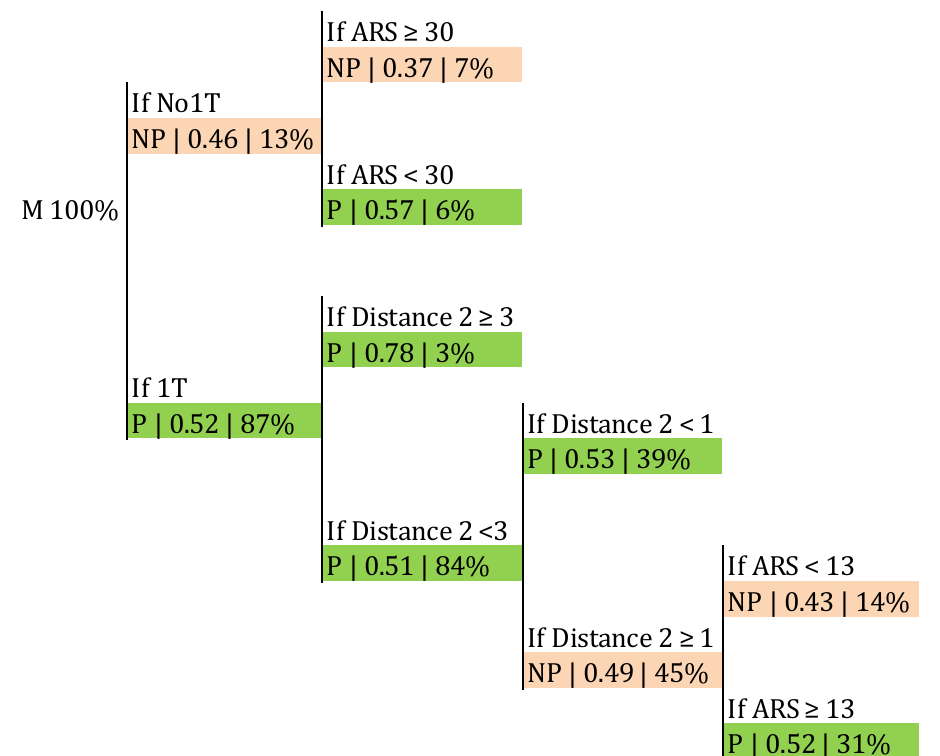
Figure 8. Probability of a point in the side-out depending on the availability of first tempo, Distance 2, and ARS.